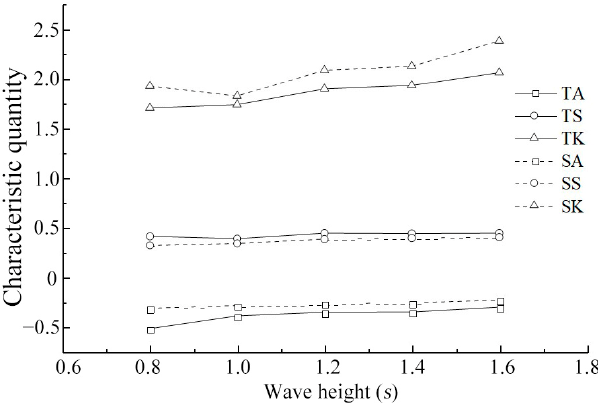
Figure 10. Distribution of nonlinear characteristic quantities with wave